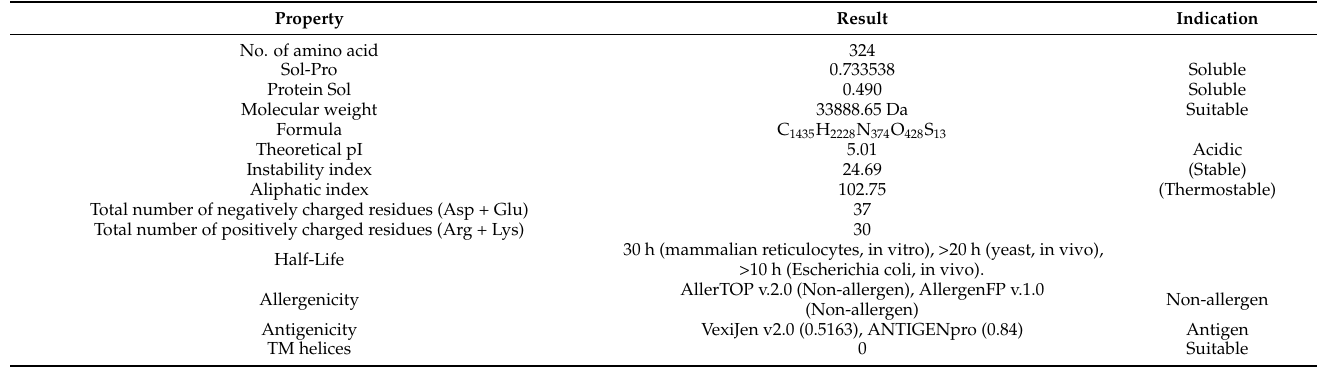
Table 3. Estimated immunological and physicochemical properties of the designed vaccine